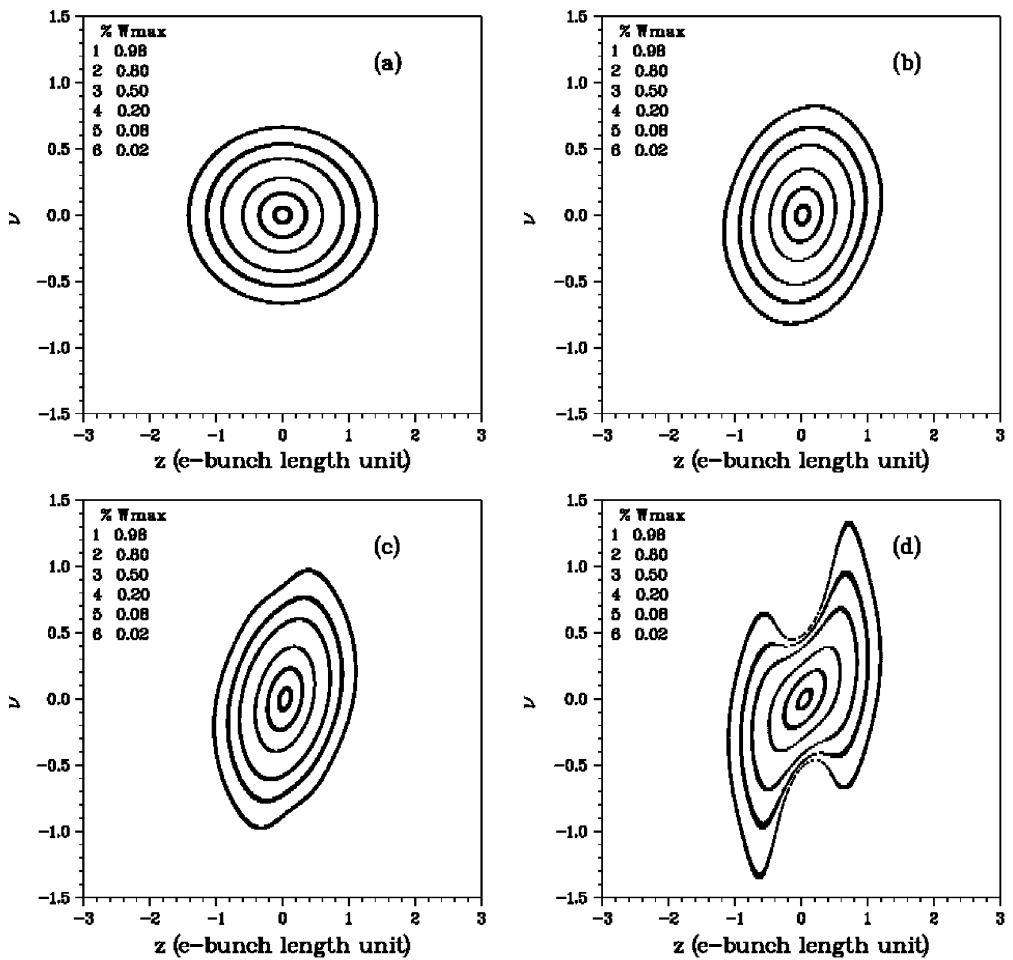
FIG. 5. Wigner phase space contour plots from PROMETEO simulation; same parameters as in Fig. 1: (a) Z ¼ 0 m , W max ¼ 1 : 25 (cid:2) 10 (cid:1) 2 ; (b) Z ¼ 3 : 08 m , W max ¼ 3 : 36 (cid:2) 10 (cid:1) 1 ; (c) Z ¼ 6 : 16 m , W max ¼ 6 : 96 (cid:2) 10 1 ; (d) Z ¼ 7 : 98 m , (saturation) W max ¼ 4 : 31 (cid:2) 10 2